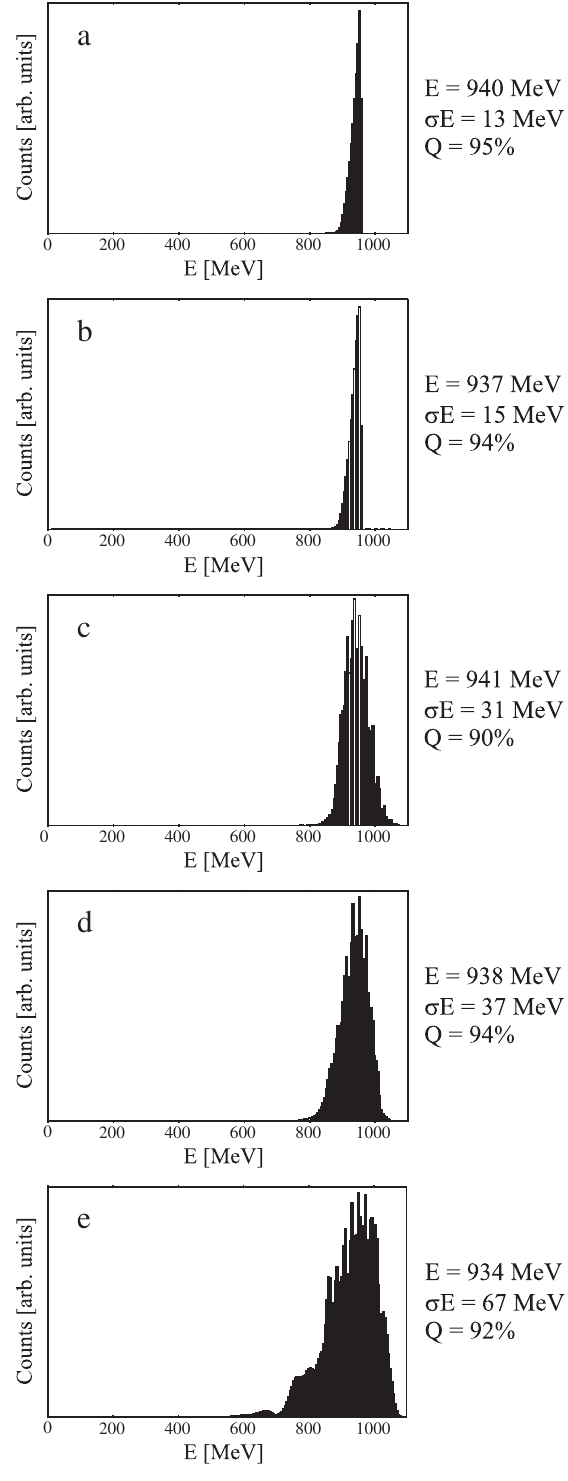
¼ 150 fs , (c) Laser pulse t ¼ 10% n e